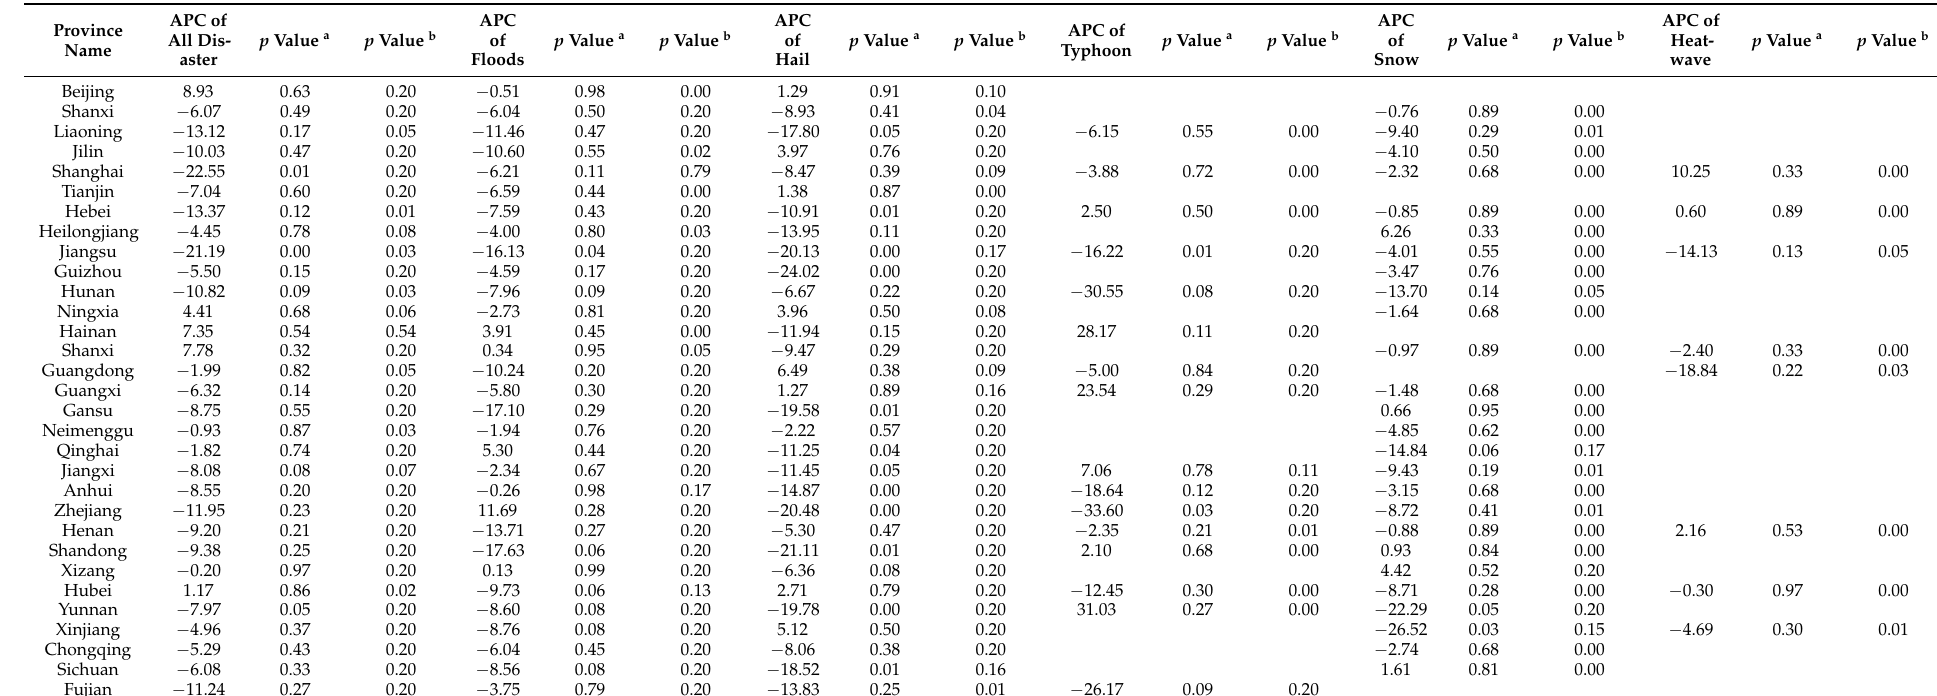
Table 2. APC (%) of mortality caused by meteorological disasters at provincial level,